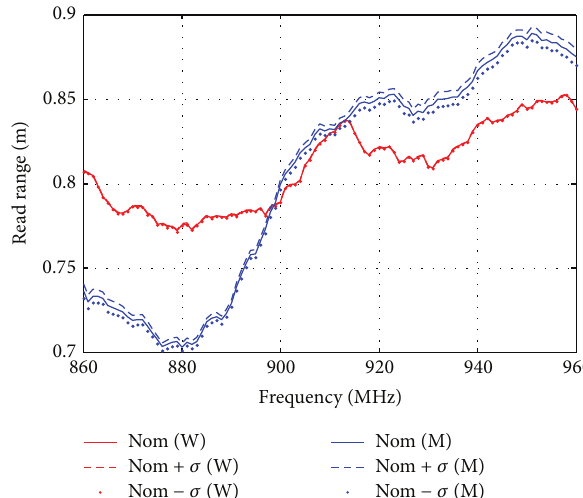
Figure 8: Reference response measurement results ( 𝐸 -plane) for the chest case for woman (W) and man (M). The measurements are based on 20 repetitive threshold power measurements.